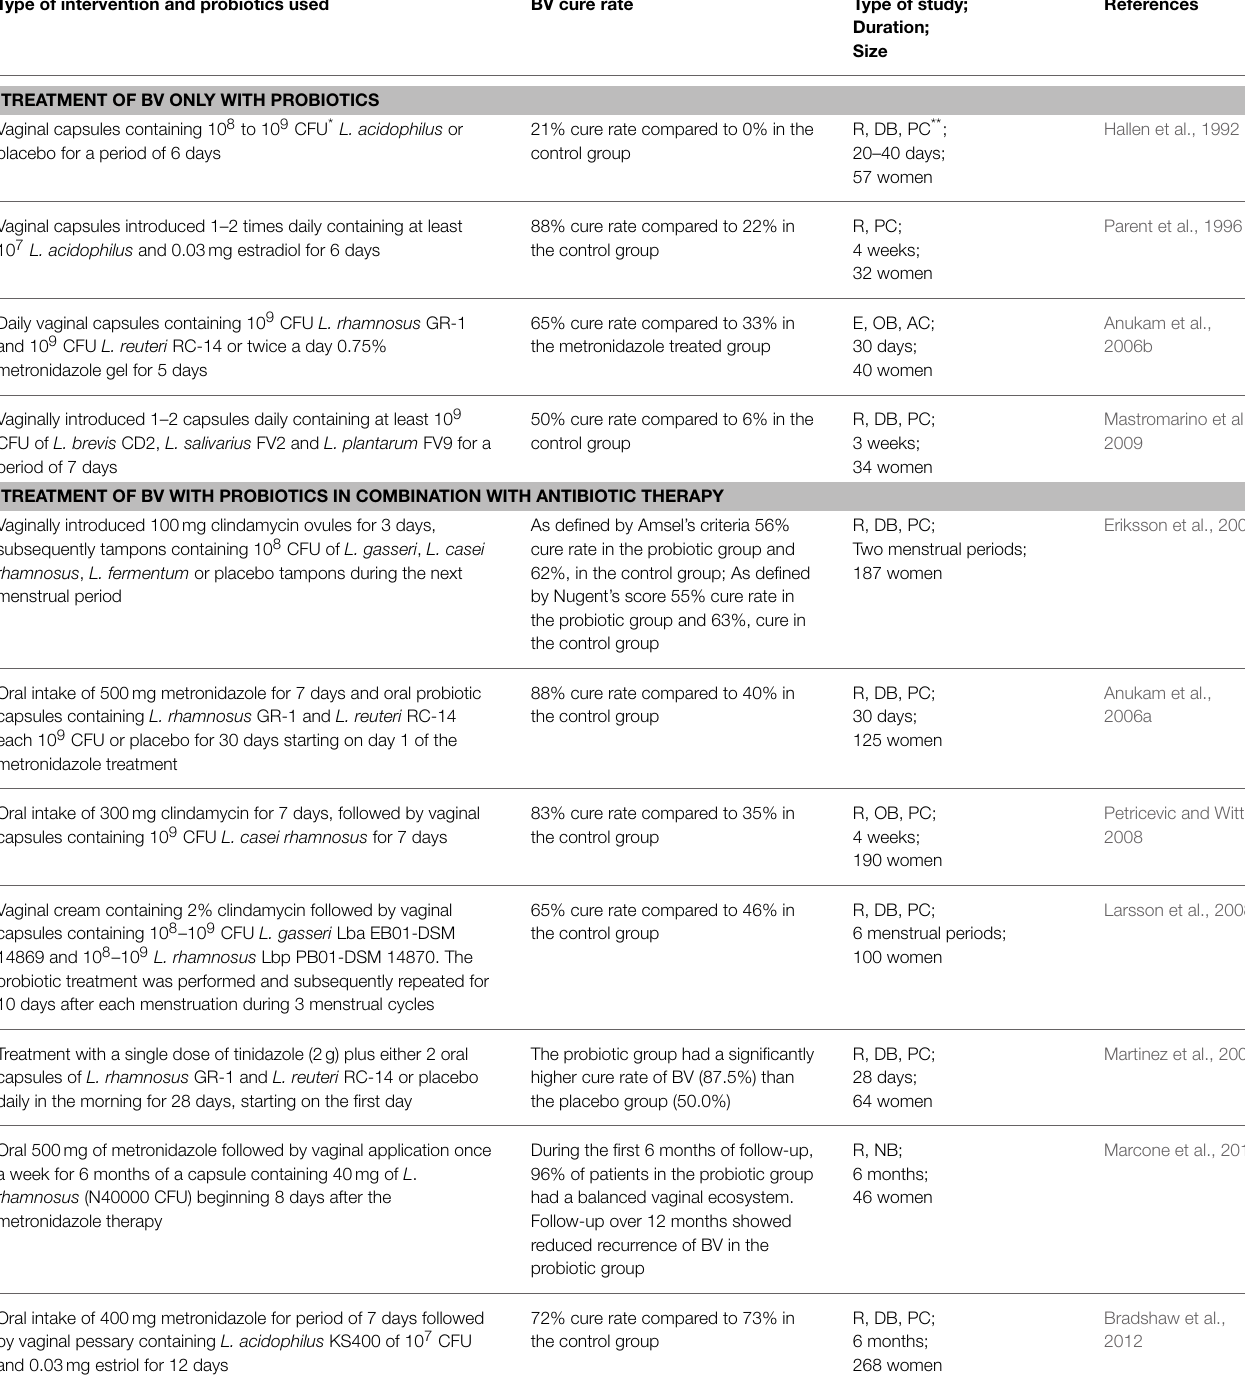
TABLE 1 | Use of probiotic strains for the treatment of BV. Type of intervention and probiotics used BV cure rate Type of study;